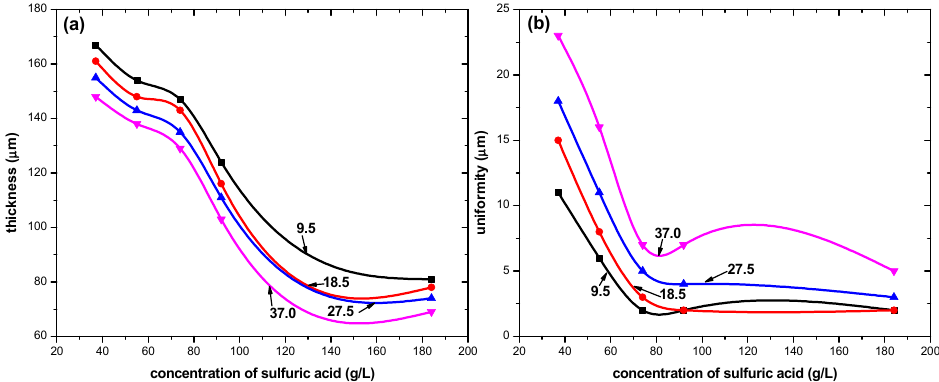
Figure 3. Influence of sulfuric and phosphoric acid concentration on the ( a ) thickness and ( b ) uniformity of AAO coating.